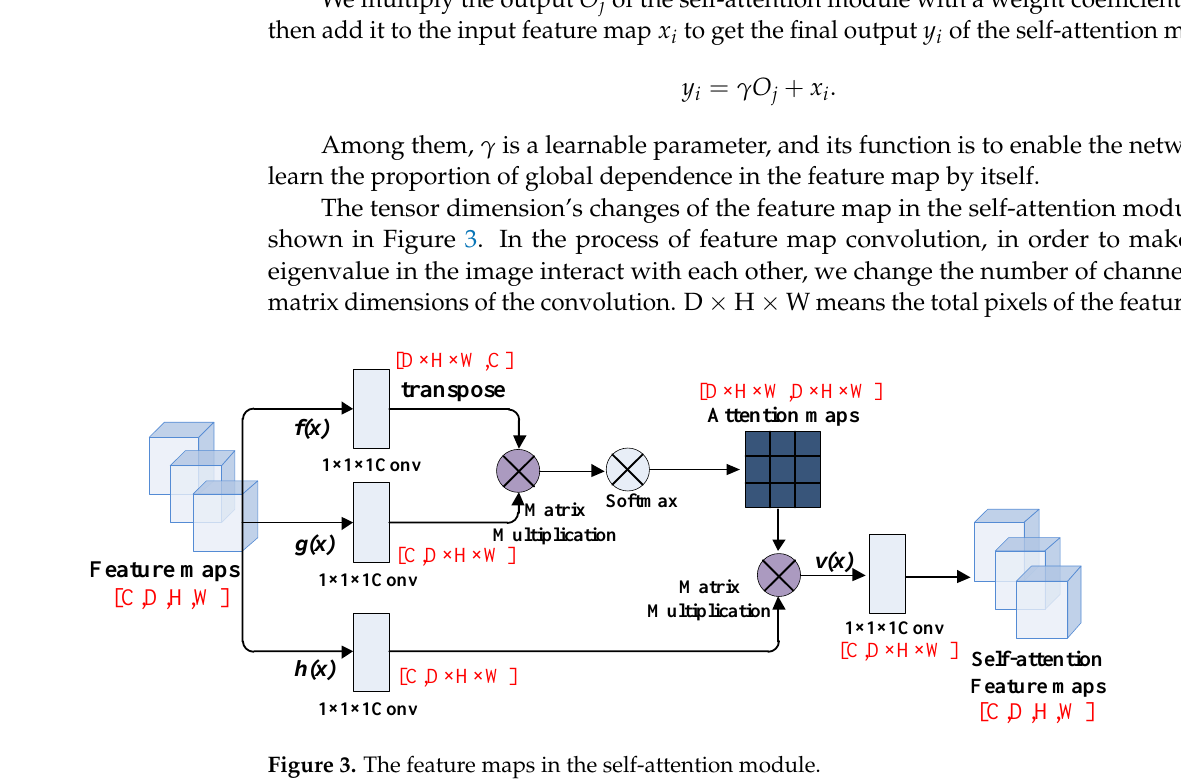
Figure 3. The feature maps in the self-attention module.